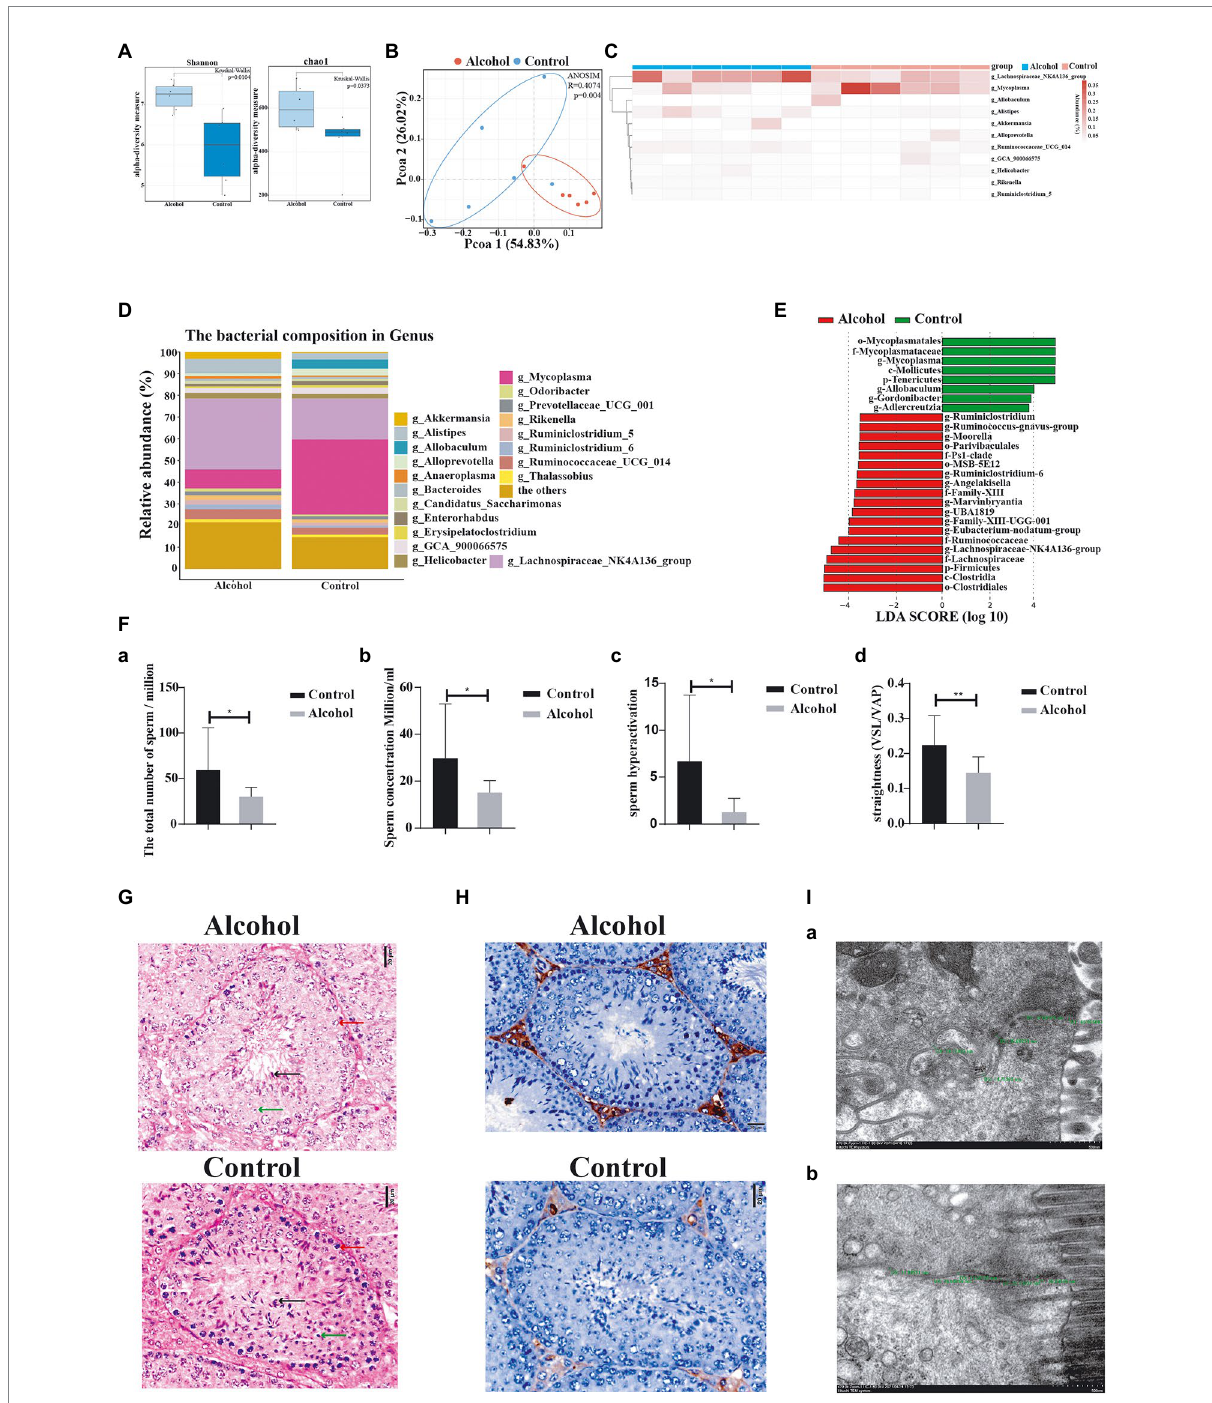
FIGURE 2 Chronic alcohol consumption (alcohol) altered the gut microbiota and impaired sperm quality. (A) Alpha diversity (based on the Shannon and Chao1 index). (B) pCoA of beta diversity. (C) Heatmap of selected differentially abundant features. (D) Relative abundance of the indicated genus. (E) LEfSe indicating differences in the bacterial taxa between alcohol and control group mice. Green bars indicate taxa enriched in control mice, and red bars indicate taxa enriched in alcohol-treated mice. (F) — (a) The total number of sperm, (b) the concentration of sperm, (c) hyperactivation of sperm, and (d) the straightness of sperm. (G) Representative images of H&E staining showing impairment of the seminiferous tubules in the testis. Scale bar = 20 μ m. (H) Immunohistochemical determination of macrophage infiltration in the testis of alcohol-treated mice. Scale bar = 50 μ m. (I) Transmission electron microscopy images measuring the intercellular space. (a) Alcohol and (b) control groups. * p < 0.05 and ** p <